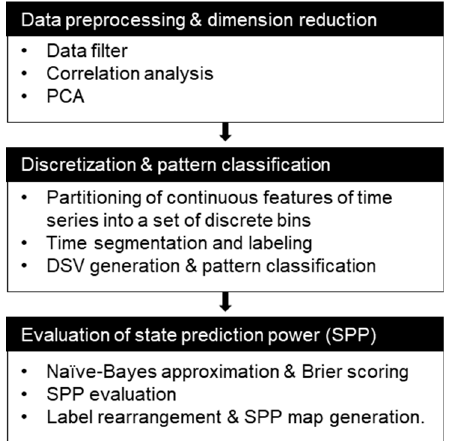
Figure 1. Overall procedure of state prediction.